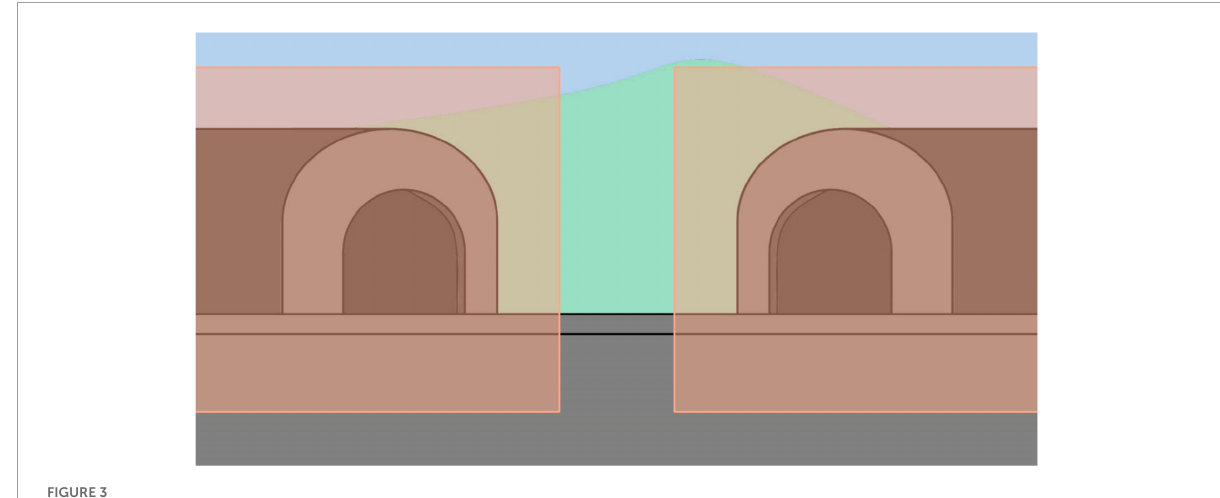
FIGURE3 Two identical Interest Areas for the left and right